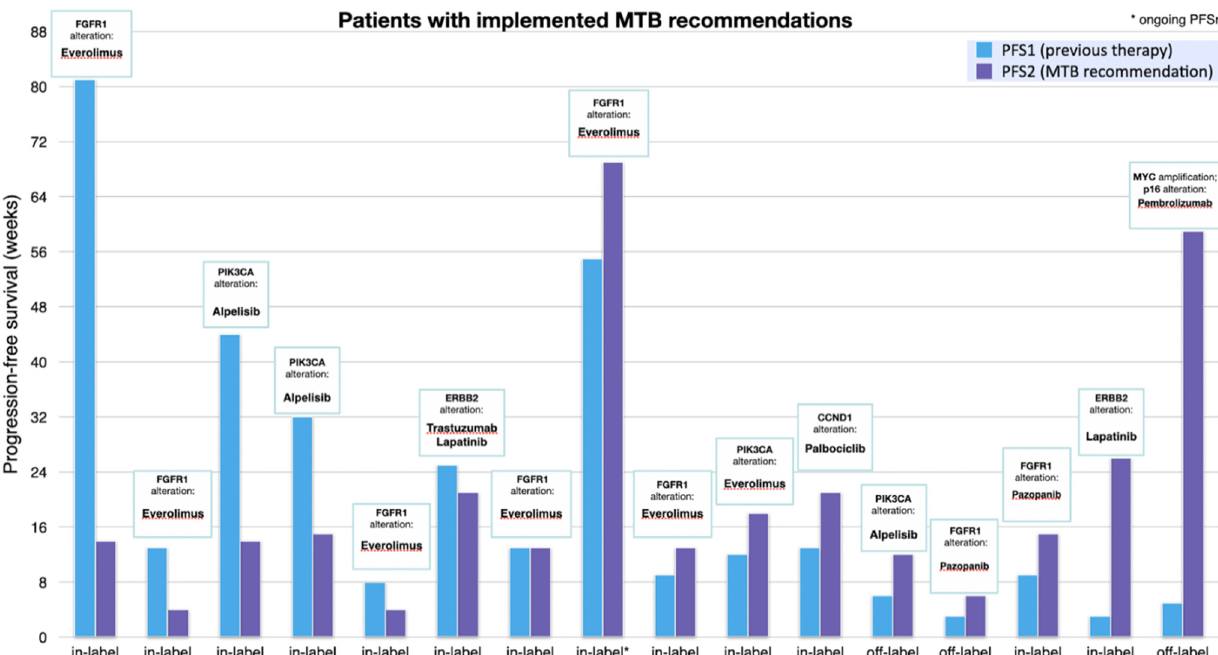
Figure 6 details the actual comparison of PFS on recommended therapy (PFS2) versus PFS on last therapy the patient received (PFS1).